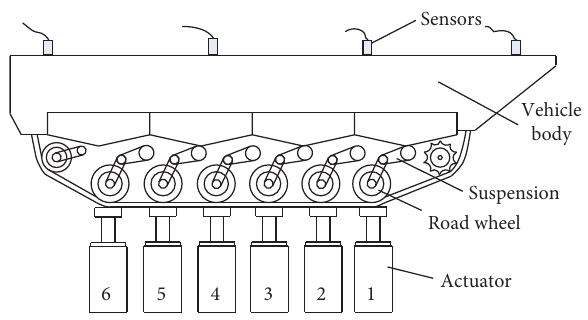
Figure 4: Schematic diagram of road simulation test